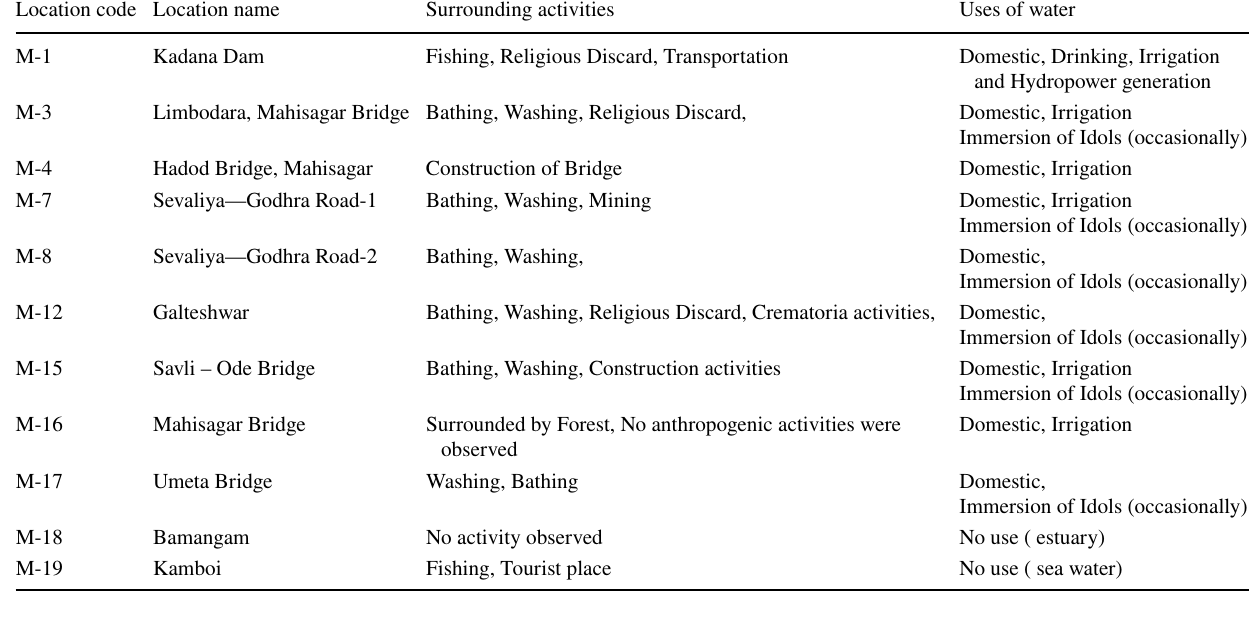
Table 1 Locations of sampling